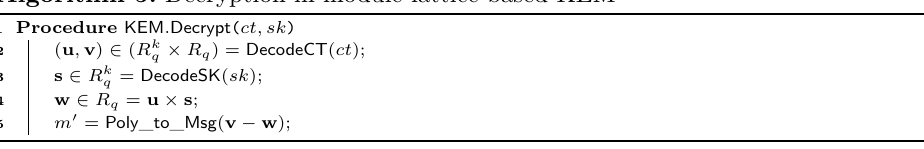
Algorithm 5: Decryption in module lattice-based